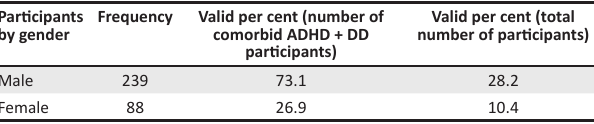
TABLE 2: The prevalence of comorbid attention deficit hyperactivity disorder and developmental dyslexia ( n = 327). Participants by gender